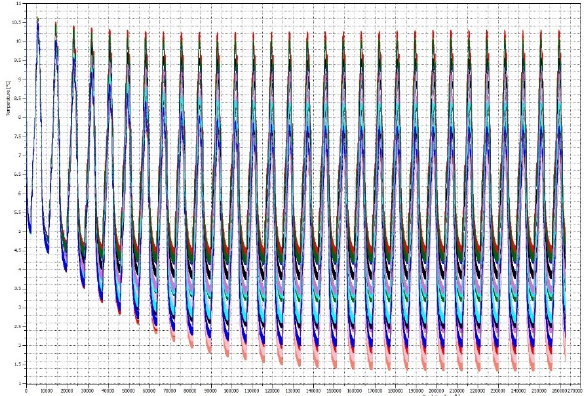
Figure 11. Average temperature of BHEs within the 2nd scenario (system with space cooling) during 30 years of